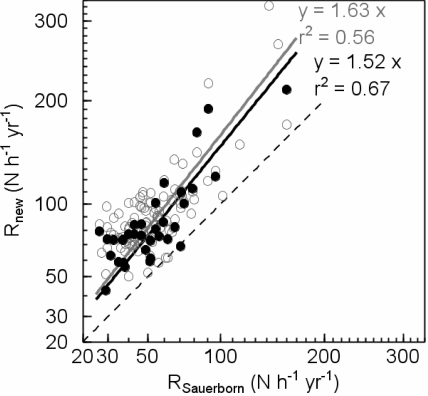
Figure 6. Comparison of past mean erosivities derived from rain gauge data of the 1960s to 1980s as reported by Sauerborn (1994) with recent mean erosivities of the 2000s to 2010s. Recent erosiv- ities were either determined from rain gauge data at the same me- teorological stations (mean of 2001 to 2016; taken from Fischer et al., 2019; n = 33; filled circles) or from radar data (mean of 2001 to 2017 and all radar pixels at a distance of < 1 . 5km from the me- teorological stations; n = 101, open circles). Both axes are square root scaled to improve resolution at low erosivities. Dashed line de- notes 1 : 1. Solid lines are regressions through the